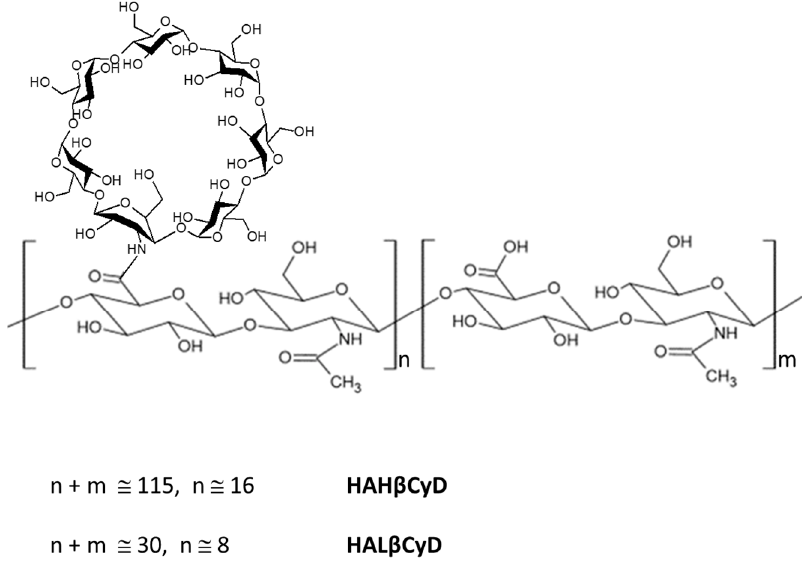
Figure 1. HA β -Cyclodextrin conjugates HAH β CyD and HAL β CyD.